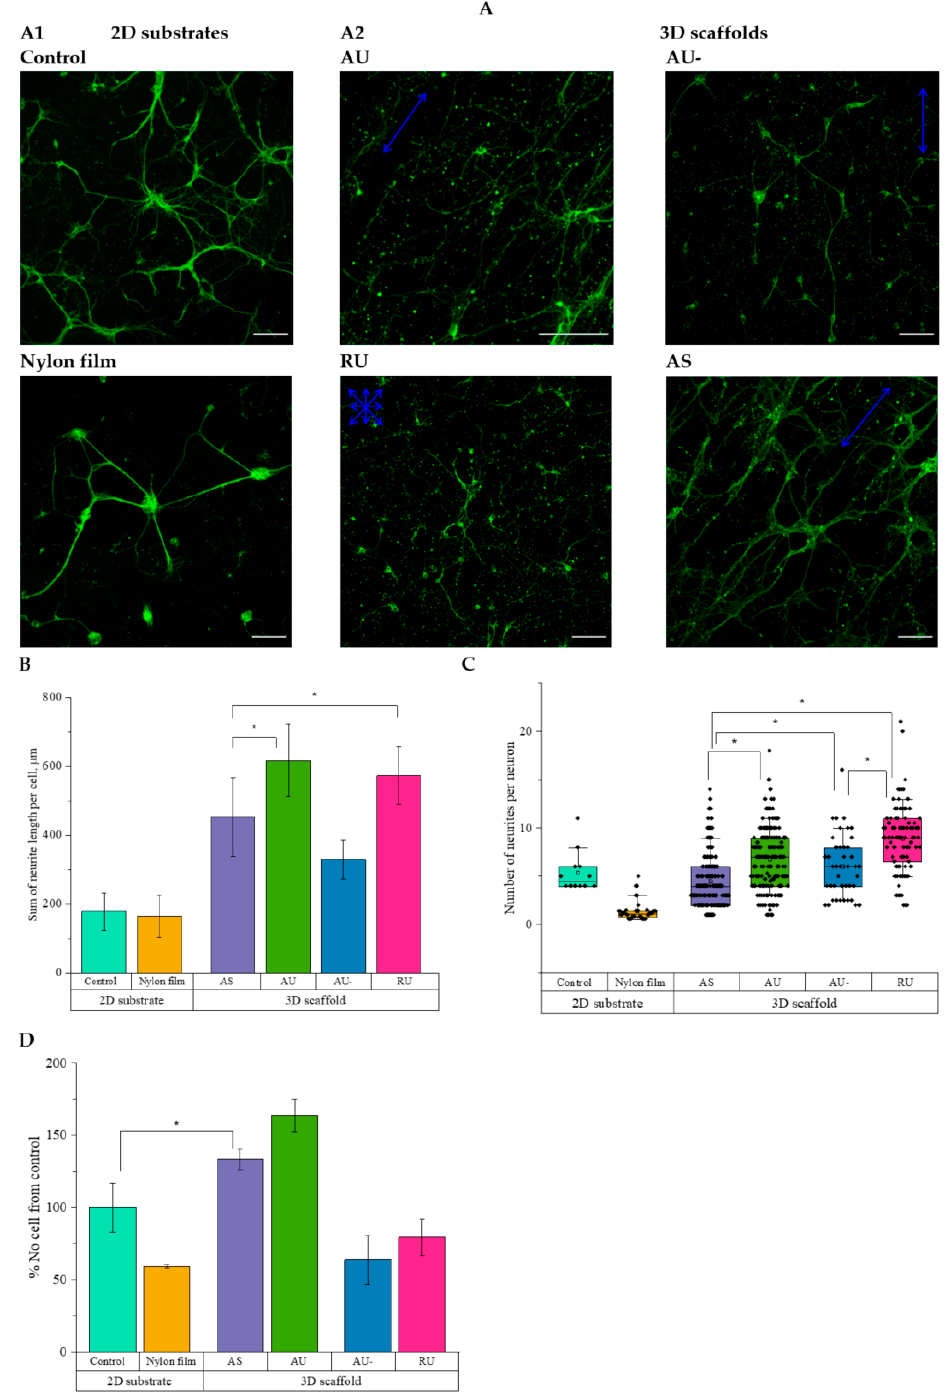
Figure 3. The effect of scaffold surface ultrastructure on the morphology of rat hippocampal neurons. ( A ) Confocal images of neurons growing on different substrates. Control—a poly-D-lysine-coated slide; only AU fibers were not treated with plasma (AU-). Coloring: green— β -tubulin. Blue arrows indicate the direction of fiber packing; intersecting arrows indicate randomly oriented fibers. Scale bar—75 µ m. ( B ) Total elongation of neurites per cell during cultivation on 2D and 3D substrates; ( C ) Number of neurites per neuron. The dots correspond to the obtained values; boxes and bars correspond to 25–75% and 10–90% percentiles, consequently; horizontal lines represent median values. ( D ) Number of cells in an area 0.25 mm 2 as a percentage of control. At least 40 cells were analyzed for each type of substrate. * statistically significant difference, p <